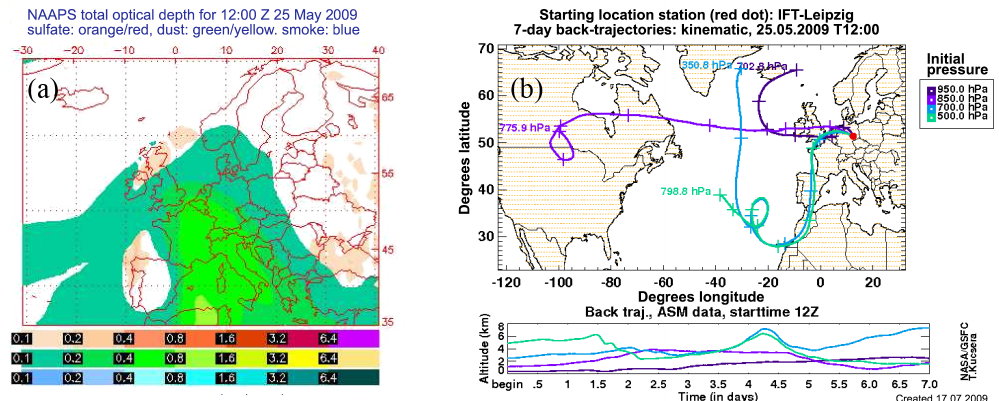
Figure 3. EARLI09 intercomparison experiment: (a) NAAPS Total Optical Depth forecast, 25 May 2009 at 12:00UTC; (b) 7-day back trajectories ending over Leipzig, Germany at 12:00UTC on 25 May 2009.